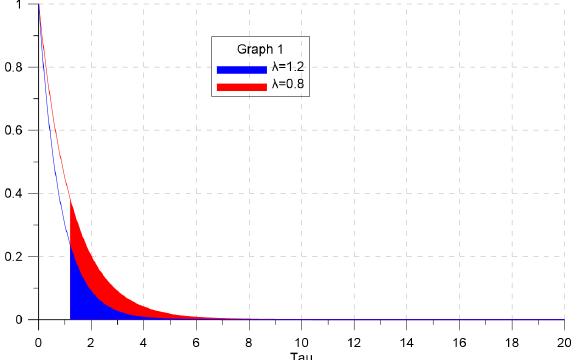
Figure 4. The probability of false alarm according to λ